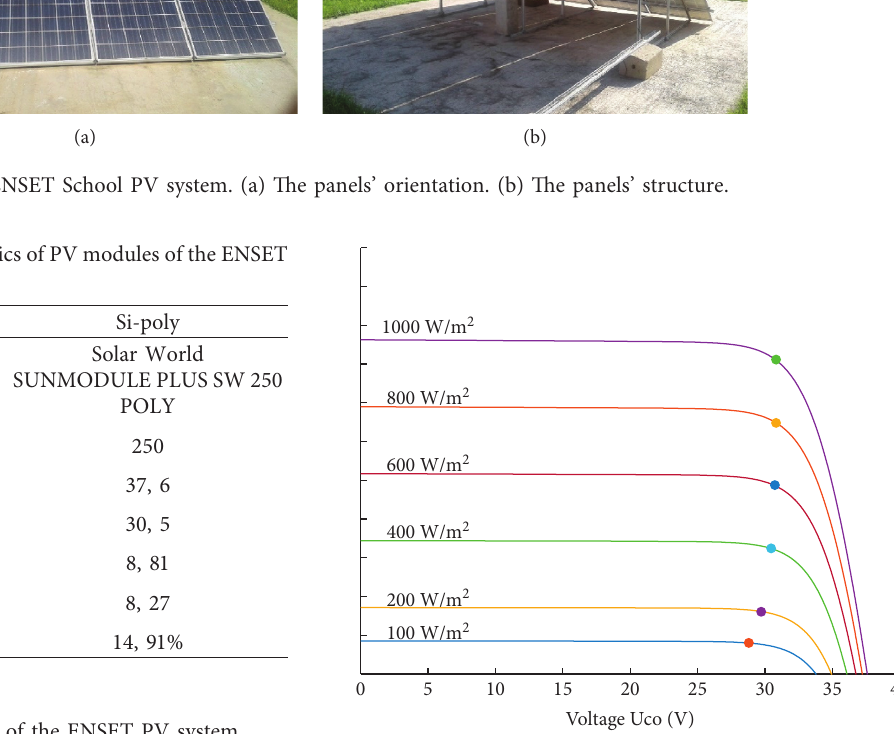
Figure 4: The IV curve provided by the model of the installed PV panel of brand SUNMODULE PLUS SW 250 POLY; the simulation used diverse values of plan of array irradiance (POA).